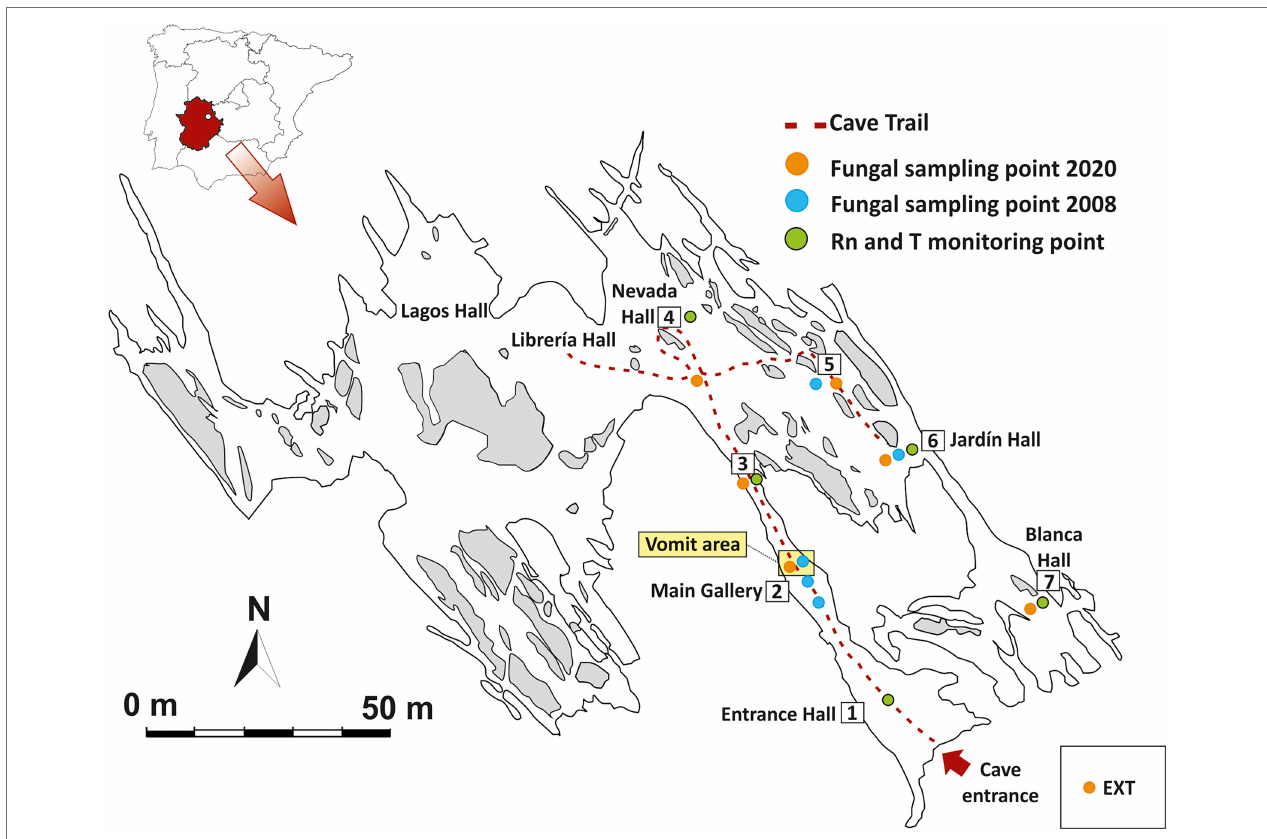
FIGURE 1 | Map of Castañar Cave with location of sampling points, passive radon dosimeters and thermohygrometer recorders for environmental monitoring. EXT: